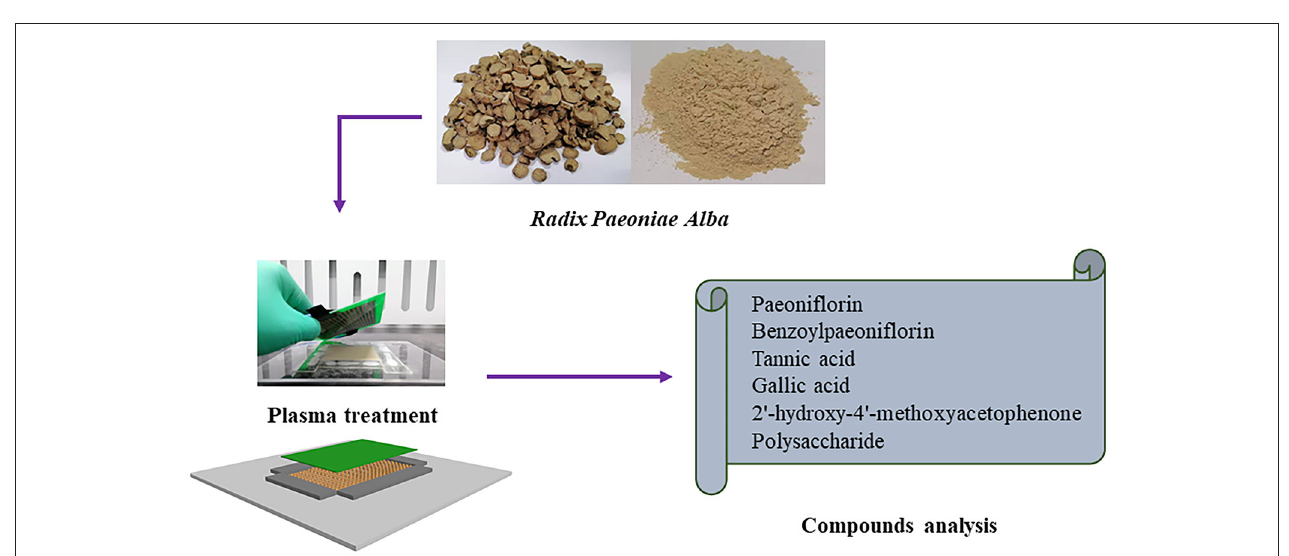
FIGURE 1 | Schematic diagram of experimental design and DBD plasma treatment.